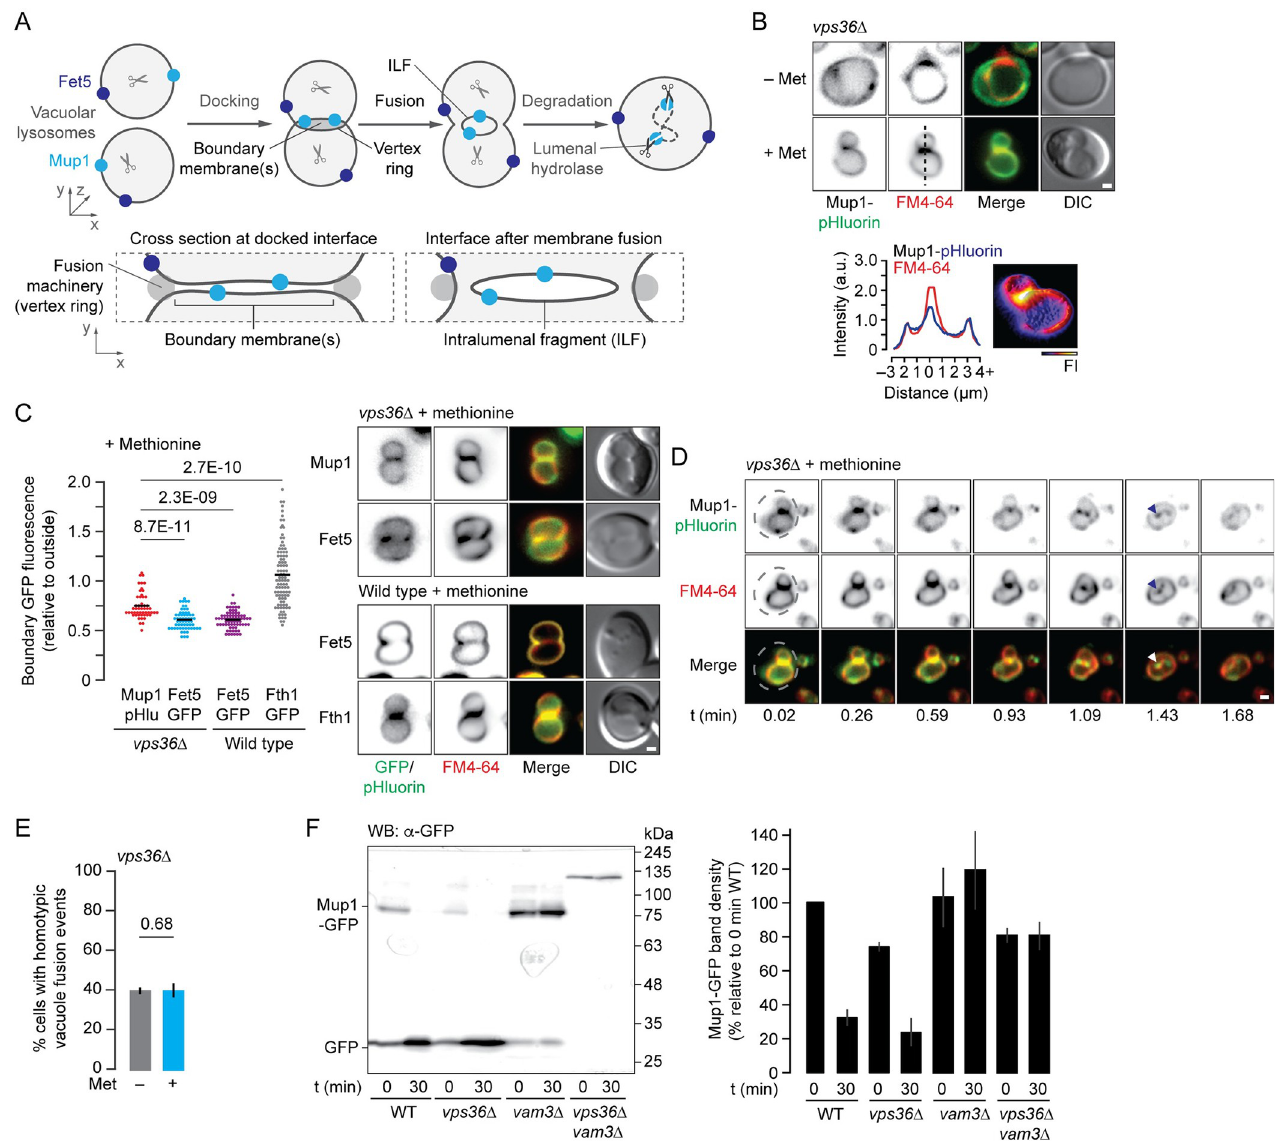
Fig 3. Methionine triggers Mup1 degradation by the ILF pathway in vps36 Δ cells. (A) Cartoon illustrating how Mup1 on vacuole membranes may be sorted into boundaries and ILFs formed during homotypic vacuole fusion. Whereas Fet5 is depleted from boundaries and ILFs, and exclusively resides on outside membranes. (B) Fluorescence and DIC micrographs of live vps36 Δ cells stained with FM4-64 expressing pHluorin-tagged Mup1 before or 10 minutes after addition of methionine. A 3-dimensional Mup1-pHluorin fluorescence intensity (FI) plot and line plots of pHluorin or FM4-64 fluorescence intensity (line shown in above micrograph) indicate boundary membrane localization after methionine addition. (C) Mup1-pHluorin, Fet5-GFP or Fth1-GFP fluorescence measured within boundary membranes of docked vacuoles within live wild type or vps36 Δ cells in the presence of methionine. 52 (Mup1-pHluroin, vps36 Δ ), 82 (Fet5-GFP, vps36 Δ ), 70 (Fet5-GFP, wild type), 97 (Fth1-GFP, wild type) boundaries were analyzed. Mup1-pHluorin was absent from vacuole membranes without methionine and thus was not analyzed. (D) Snapshots from time-lapse movie showing a homotypic vacuole fusion event within a live vps36 Δ cell expressing Mup1-pHluorin stained with FM4-64 10 minutes after methionine addition. Dotted lines indicate cell perimeter; arrowheads indicate newly formed ILF. See S1 Video. (E) Analysis of data shown in D indicating proportion of vps36 Δ cells that displayed a vacuole fusion event within 5 minutes before (n = 1,446) or 10 minutes after methionine addition (1,057). (F) Western blot analysis (left) of whole cell lysates prepared from wild type (WT), vps36 Δ , vam3 Δ , or vps36 Δ vam3 Δ cells expressing Mup1-GFP before (0 minutes) or 30 minutes after addition of methionine. Estimated molecular weights shown. Intact Mup1-GFP band densities relative to 0 minutes WT were calculated for each time shown (right). n = 3 for each strain tested. Means (bars) ± S.E.M. and results from Student t-test are shown. Vacuole membranes were stained with FM4-64. Scale bars, 1 μ m.